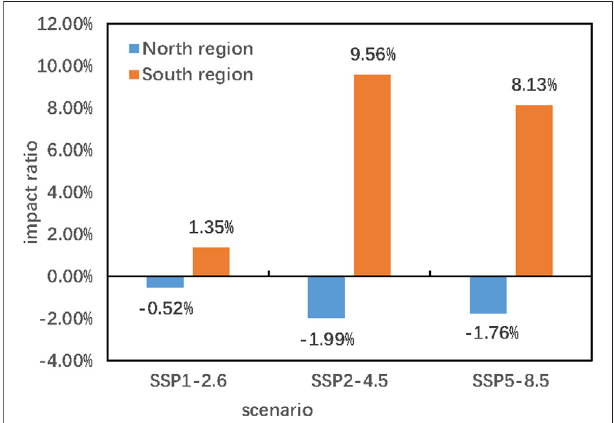
FIGURE 9 | The impact ratio of climate change in the main grain- producing areas from 2021 to